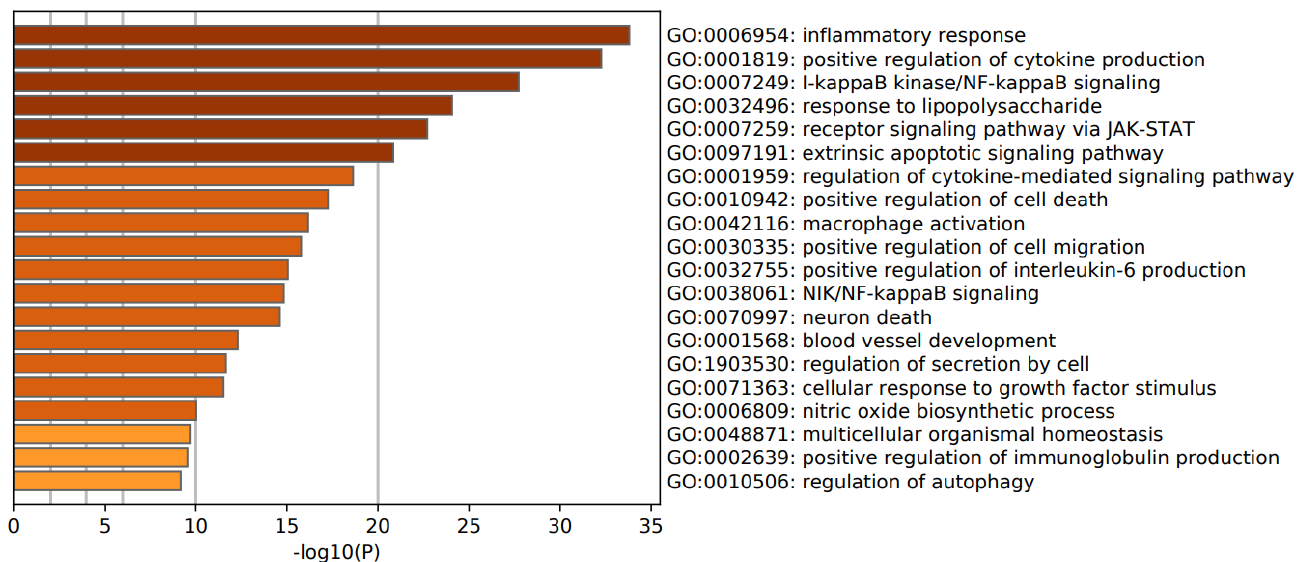
Figure 4. Heat map of enriched GO terms showing the top 20 biological functions in the first FEP/FES gene cluster (accumulative hypergeometric p -values).